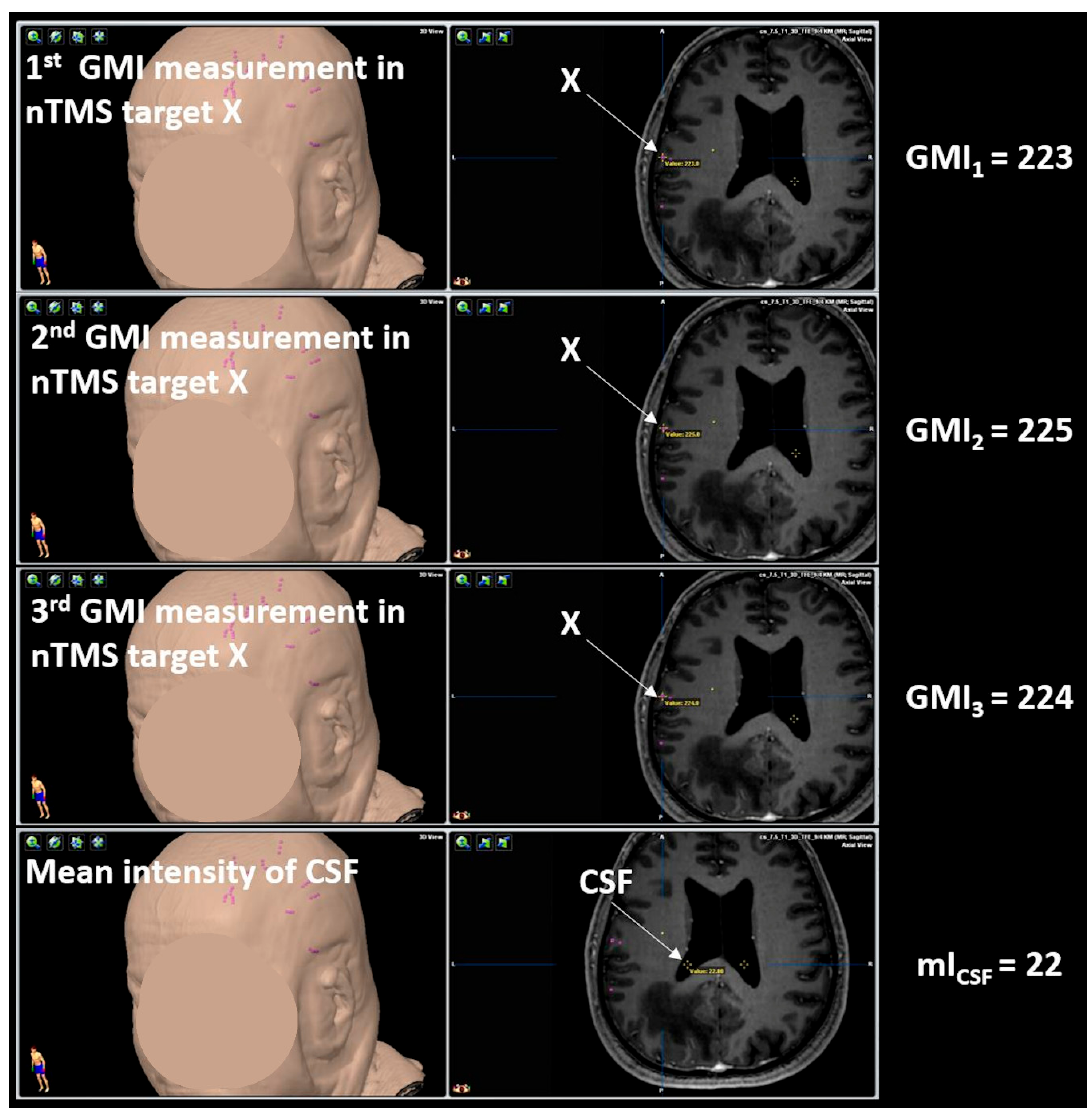
Figure 3. Analysis of gray matter intensity (GMI). The GMI of language-positive or language-negative spots, determined by language mapping using navigated transcranial magnetic stimulation (nTMS), was measured in T1-weighted sequences. Three pixels were randomly selected within a stimulation spot and used to calculate a mean GMI for language-positive nTMS spots (mGMI p ) and language-negative nTMS spots (mGMI n ). The signal intensity ratio (IR) was then calculated by dividing the mGMI p or mGMI n by the mean intensity of cerebrospinal fluid (mI csf ).